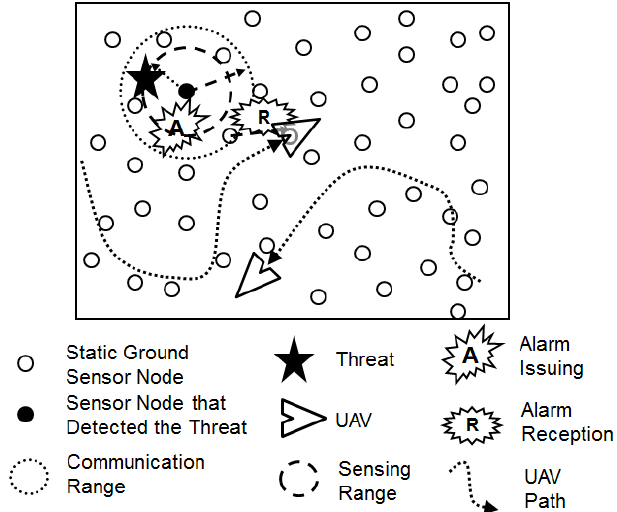
Figure 1. Overview of the application scenario illustrating threat detection, alarm issuing and alarm